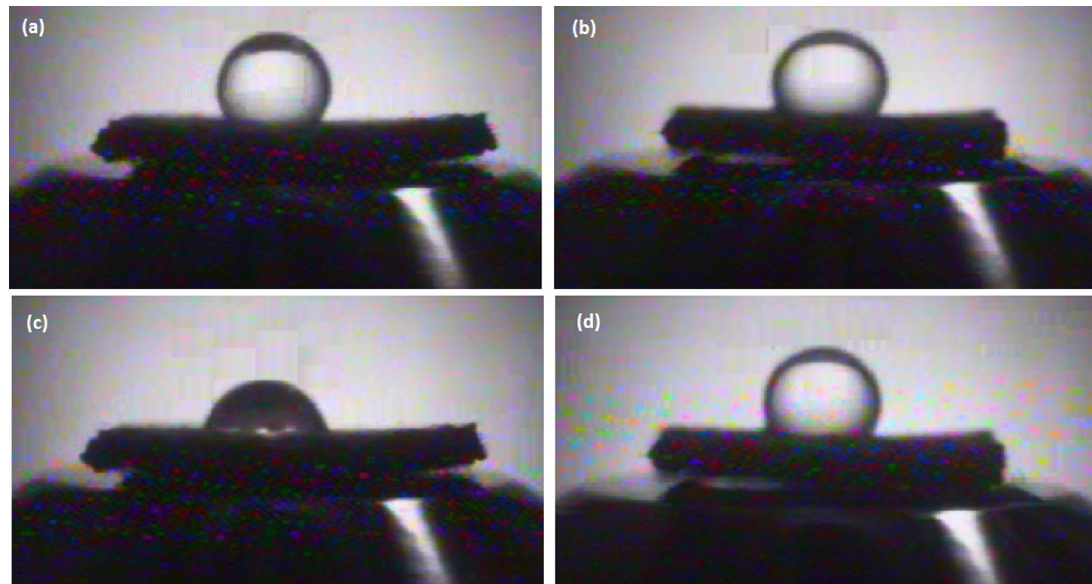
+60% O (a) Front (oxygen), outset of the 4 2